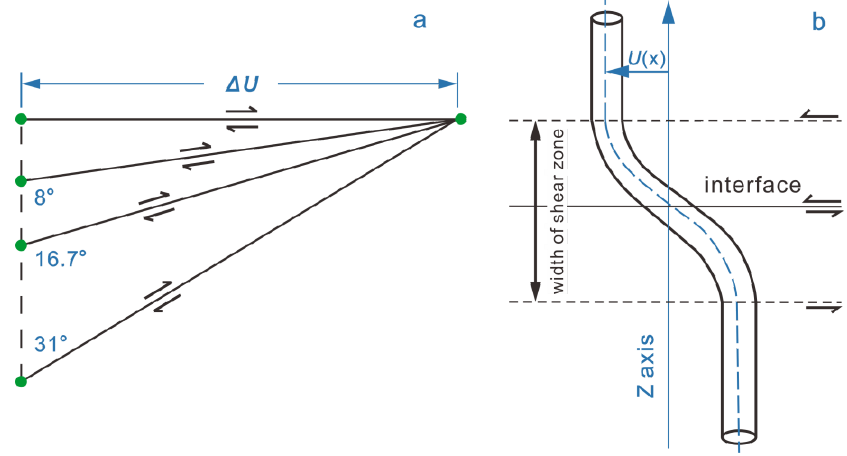
Figure 10. Shear offsets along inclined interfaces at different SDA ( a ) and S-shaped shear failure ( b ) (modified from [34]) resulting from shear-tensile or shear-compression along inclined interfaces.